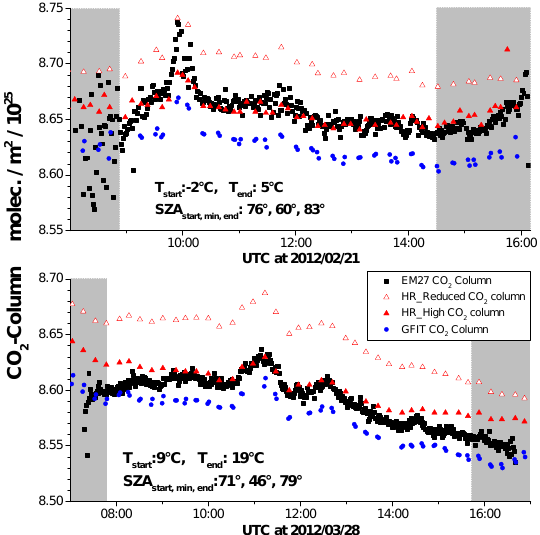
Fig. 6. O 2 columns for the four datasets for two sample days. The observed intraday variability is very low. The number of in- terferograms and respective recording interval contained in a sin- gle datapoint of each type are the following: EM27: 10 IFGs, 34s; HR Reduced: 4 IFGs, 34s; HR High: 4 IFGs, 212s; GFIT: 2 IFGs, 106s.